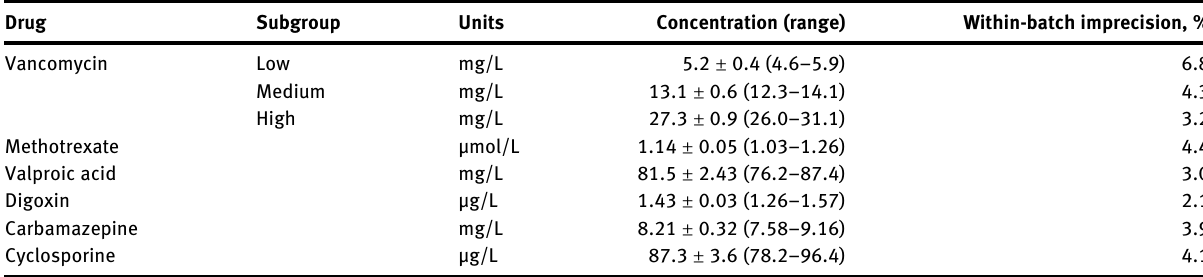
Table  : Results of within-batch imprecision analysis (n=  ). Drug Subgroup Units Concentration (range)